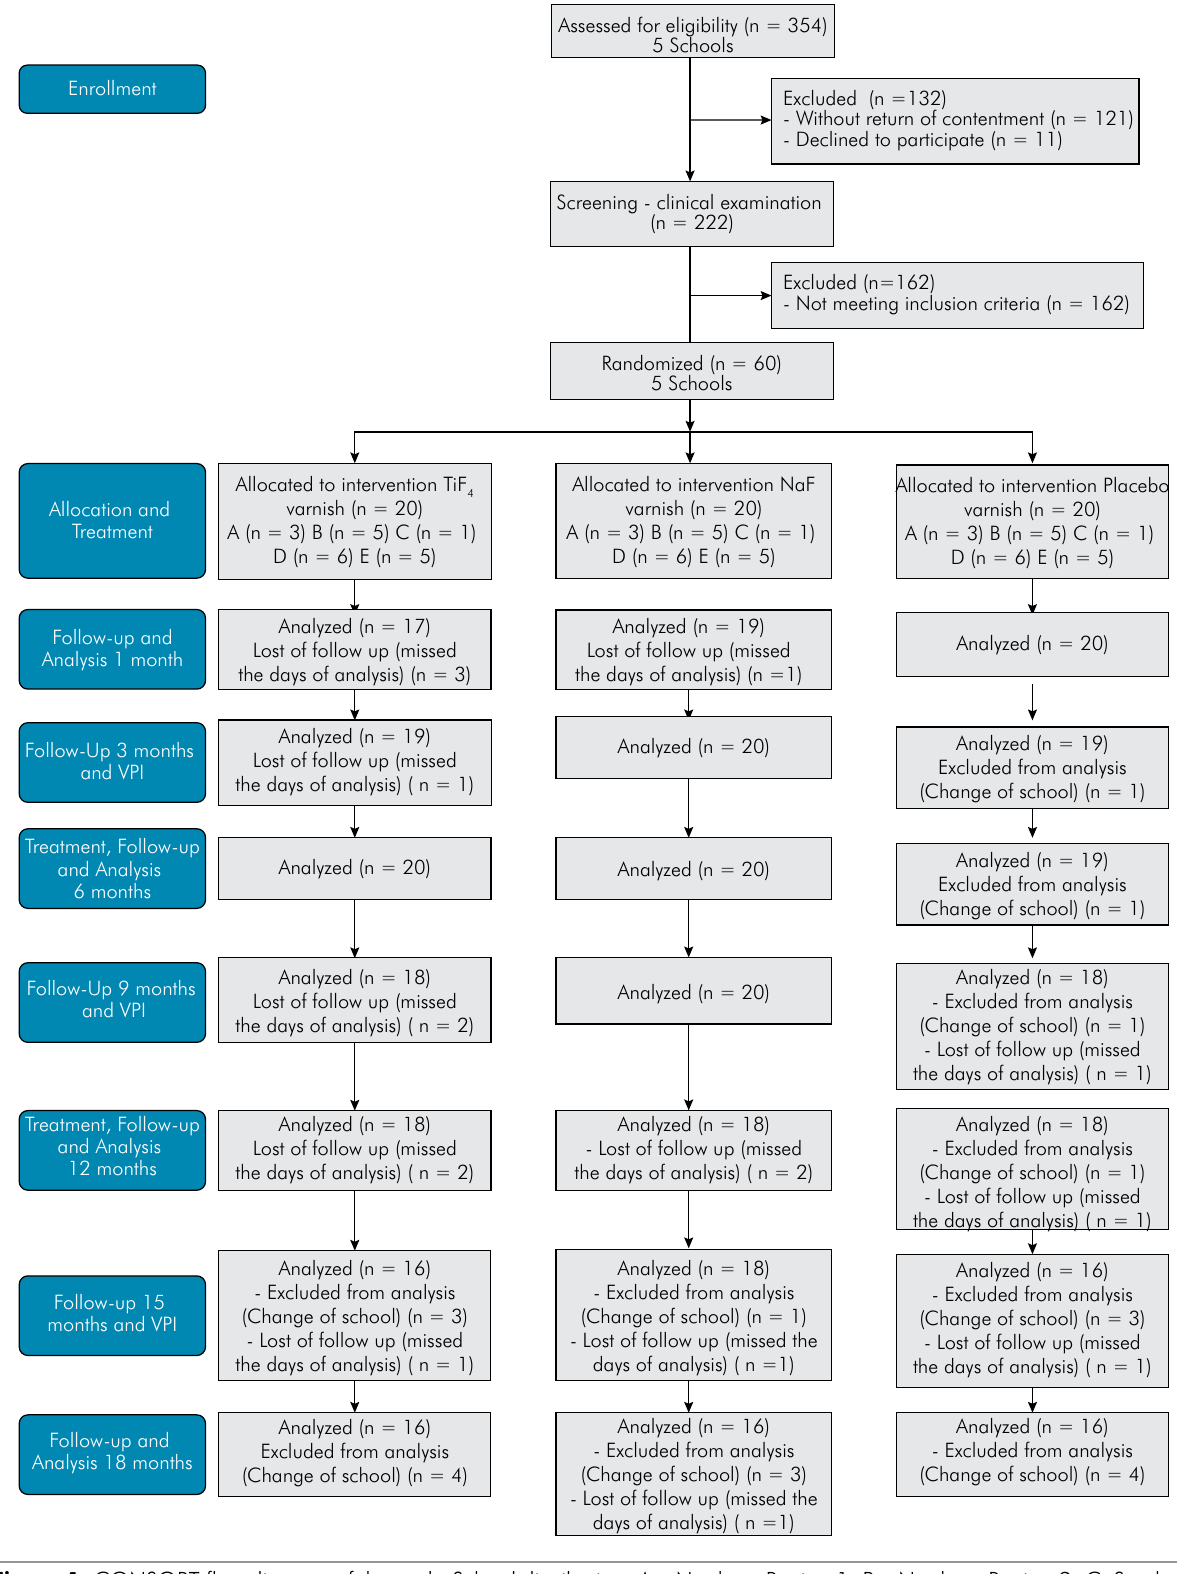
Figure 1. CONSORT flow diagram of the study. School distribution: A.– Northern Region 1; B.– Northern Region 2; C. Southern Region; D. Western Region; E. Eastern